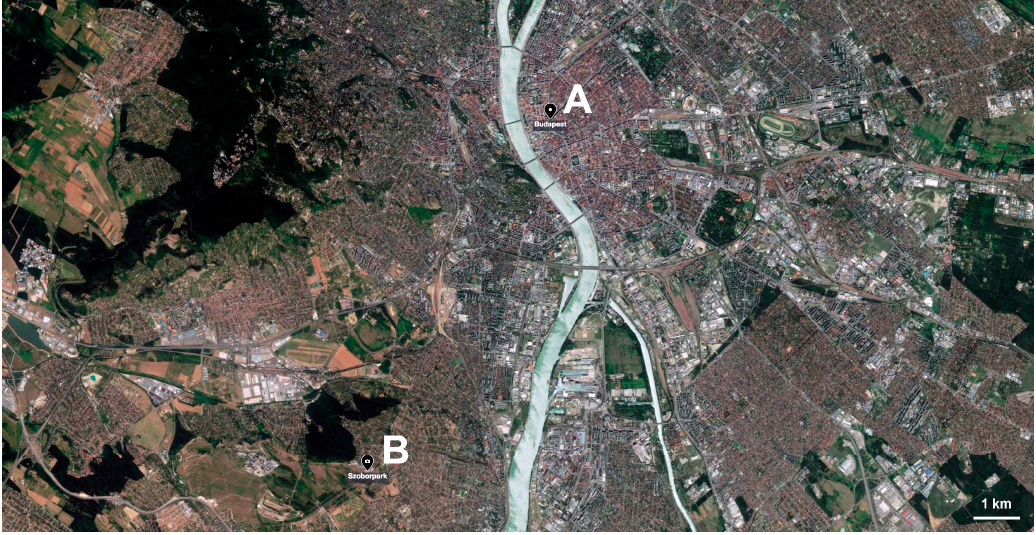
Figure 1. The center of Budapest (A), and the remote location of Memento Park in the outskirts (B). © 2018 Microsoft, Earthstar Geographics SIO & © 2018 HERE. Source: http://www.bing.com/maps/, 2018-11-09.